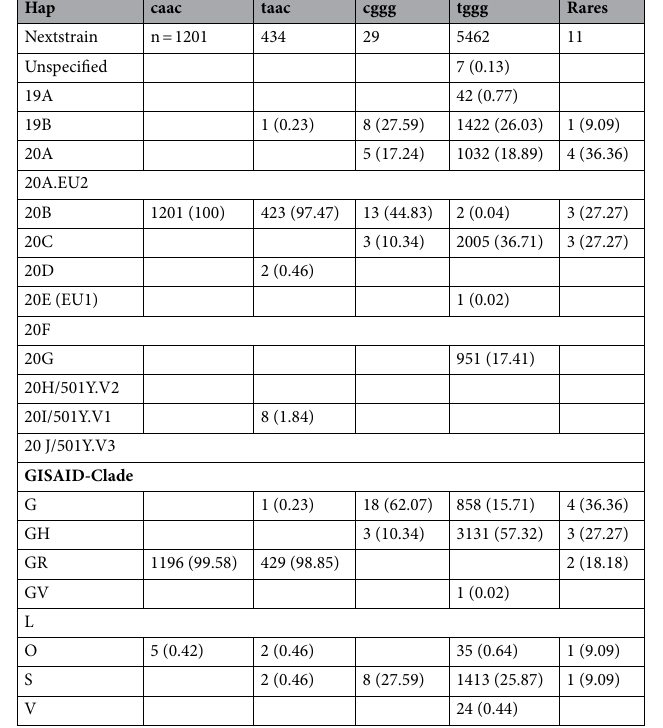
Table 5. Relationships of identified SNV haplotype (t19839-g28881-g28882-g28883) with classifications of Nextstrain and clades by GISAID.